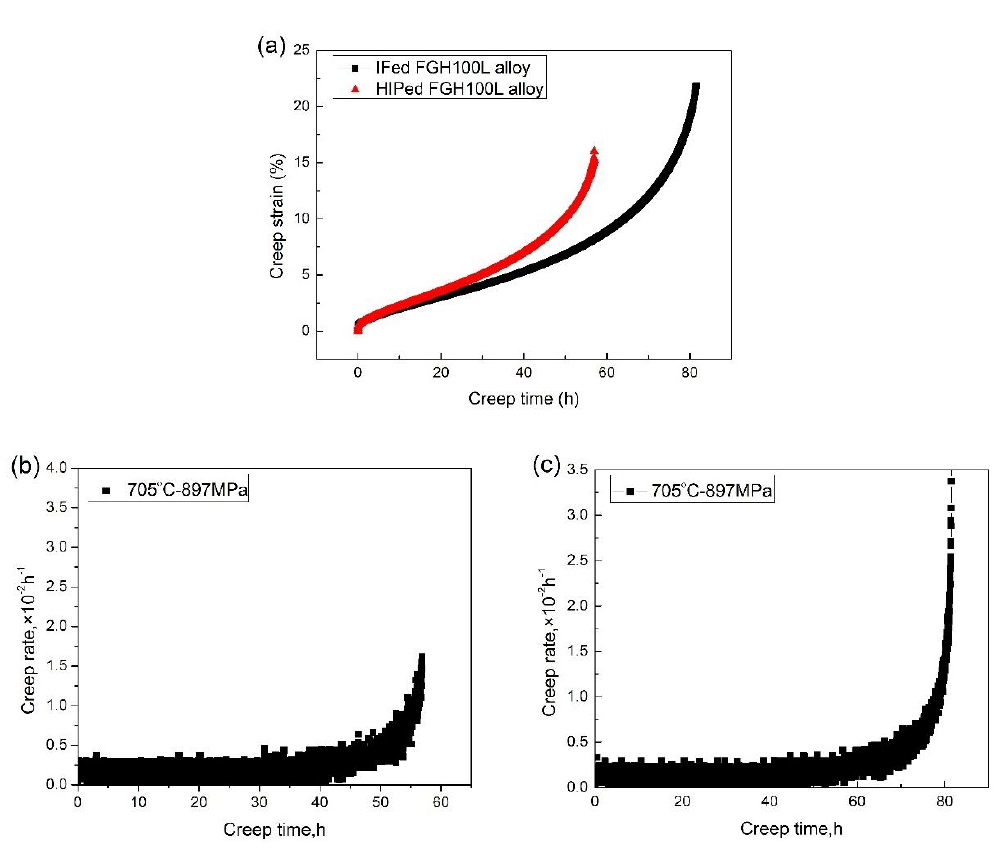
Figure 2. Creep curves of FGH100L alloy at 705 ◦ C / 897 MPa: ( a ) a comparison of strain–time relationships between the two processes, ( b ) the relationship between creep rate and the time of the HIPed alloy, and ( c ) the relationship between creep rate and the time of the IFed alloy. Table 1. Comparison of creep properties of FGH100L alloy under different processes.